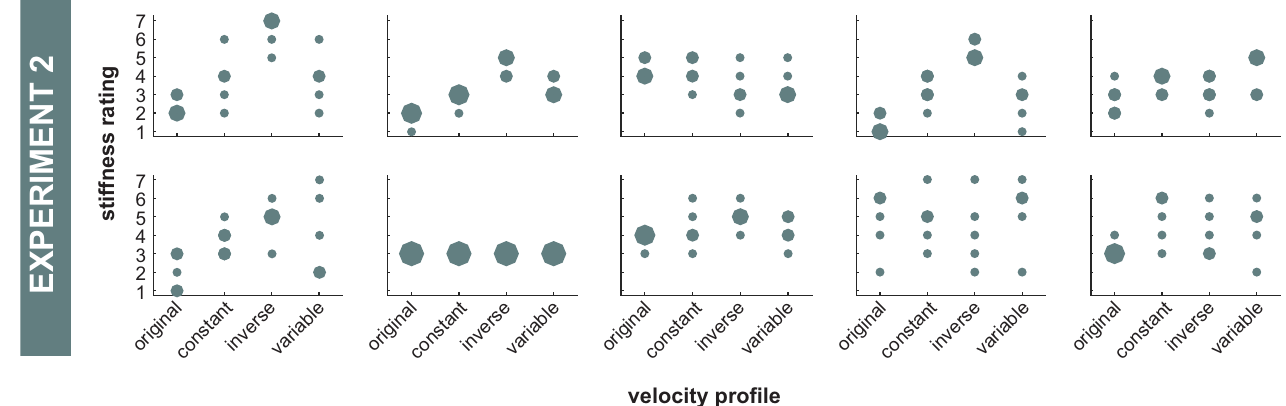
Fig 11. Experiment 2 stiffness estimates for each individual subject. All the individual subjects’ stiffness estimates across the four velocity profiles. Larger dots indicate greater response frequency.